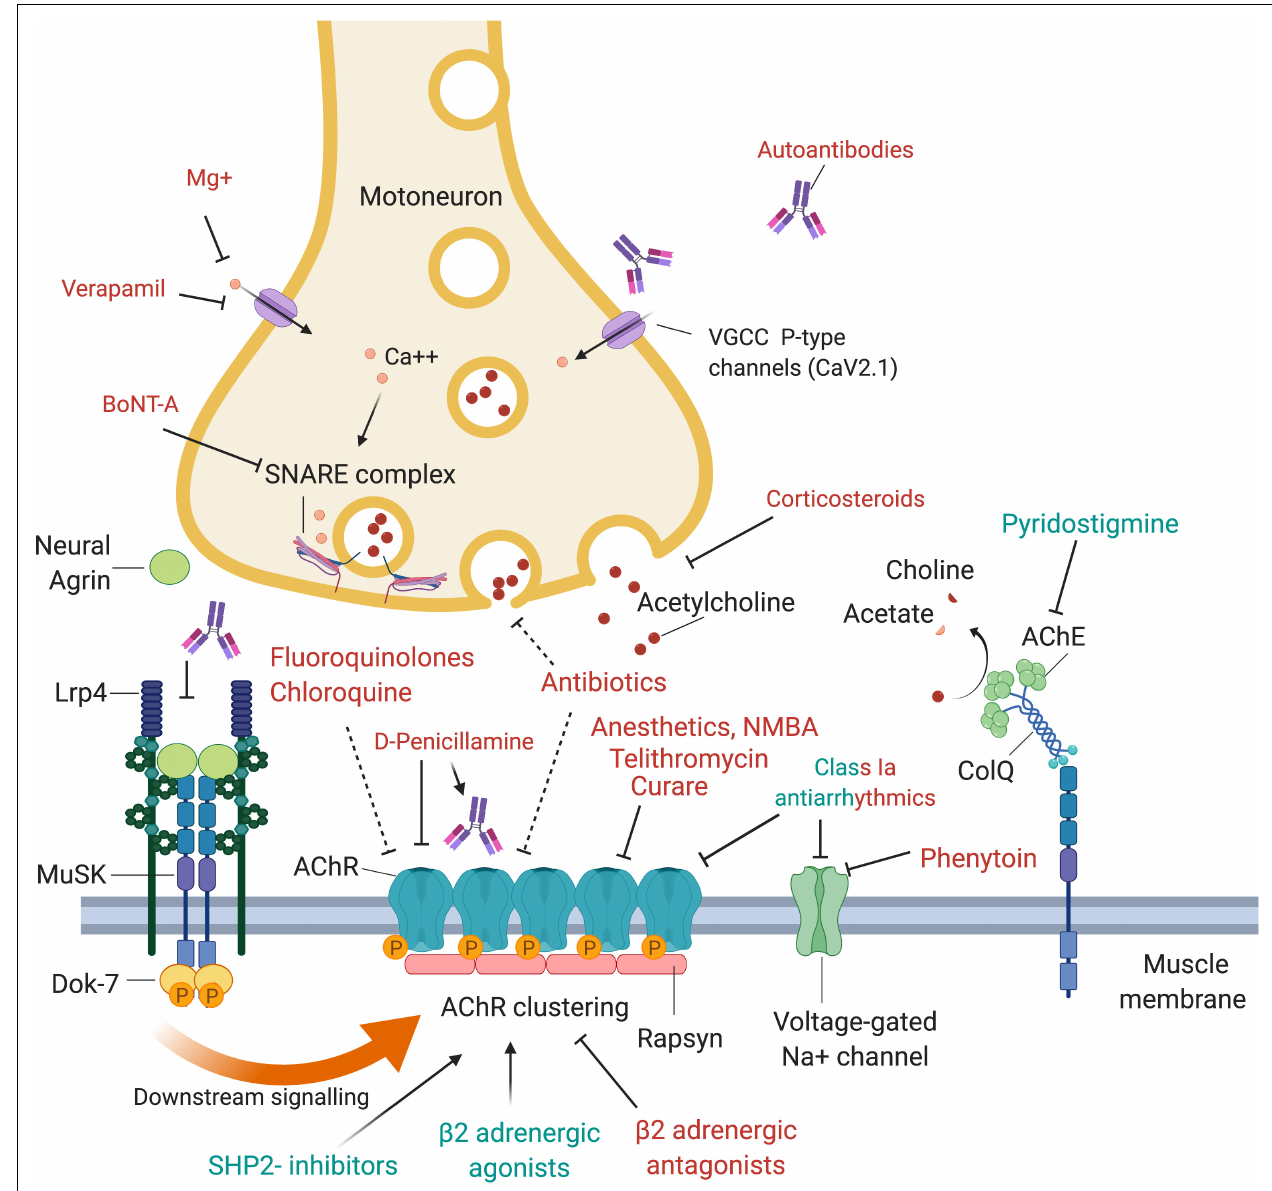
FIGURE 1 | Drugs and antibodies that affect the function of the neuromuscular junction. Upon arrival of an action potential, presynaptic P-type VGCC (voltage-gated calcium channels) open and calcium enters the motoneuron terminal. This may be negatively affected by autoantibodies that block the VGCC, Mg + or Verapamil. Calcium stimulates Ca 2 + mediated exocytosis of neurotransmitters via the SNARE complex, which is negatively affected by BoNT-A which induces cleavage of one of its components, SNAP-25. Release of acetylcholine may also be reduced by corticosteroids or antibiotics. At the postsynaptic side, AChRs are densely aggregated, which is regulated via the agrin-Lrp4-MuSK-Dok-7 signaling pathway. Neural agrin is released by the motoneuron and binds to its co-receptor, Lrp4, located in the muscle membrane. Lrp4 and agrin bind as a dimer of dimers to the muscle-specific kinase (MuSK), a receptor tyrosine kinase that then phosphorylates itself, leading to the attachment of the adapter protein Dok-7. This binding leads to a full activation of MuSK and phosphorylation of downstream molecules, cumulating in the phosphorylation and dense aggregation of AChRs. The interaction between MuSK and Lrp4 can be blocked by autoantibodies, leading to interrupted signal transduction and reduced AChR clustering. The AChR clustering can be strengthened by SHP2-inhibitors and β 2-adrenergic agonists, and de-stabilized by β 2-adrenergic antagonists. Binding of acetylcholine to the AChR leads to opening of the channel, influx of cations, depolarization of the membrane and opening of voltage-gated Na + channels, which amplifies the depolarization. A range of drugs was shown to block the AChR, including fluoroquinolones, chloroquine, antibiotics, anesthetics, NMBA, telithromycin, curare and class Ia antiarrhythmics. Quinidine, a class Ia antiarrhythmic drug, may also be beneficial in the context of slow channel CMS with a pathological prolonged open state of the AChR. Voltage-gated Na + channels are inhibited by phenytoin and class Ia antiarrhythmics. Acetylcholine is recycled in the synaptic cleft by the acetylcholinesterase (AChE), which hydrolyses acetylcholine to choline and acetate. AChE is arranged in tetramers attached to collagen q like tail (ColQ), which in turn is anchored to the synapse via binding to MuSK. AChE is inhibited by pyridostigmine, leading to prolonged presence of acetylcholine in the synaptic cleft, and is used as first line symptomatic treatment in myasthenia gravis.